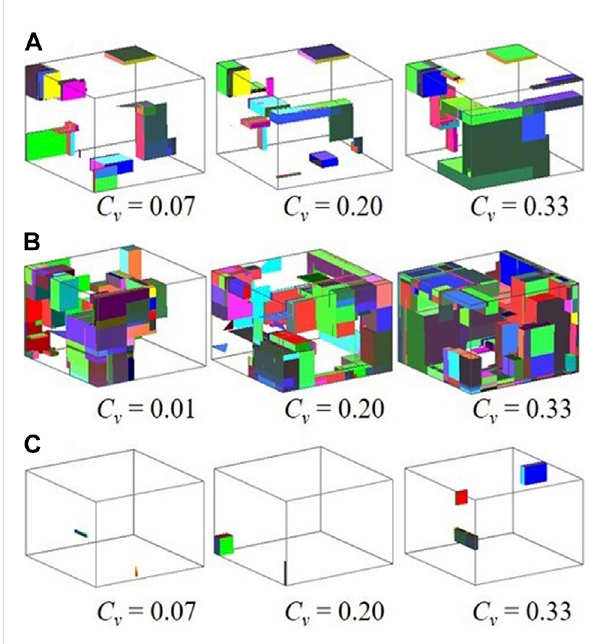
FIGURE 4 The models of rock masses produced by adopting different dispersions of fracture size: (A) model II, (B) model III, (C) model Ⅴ